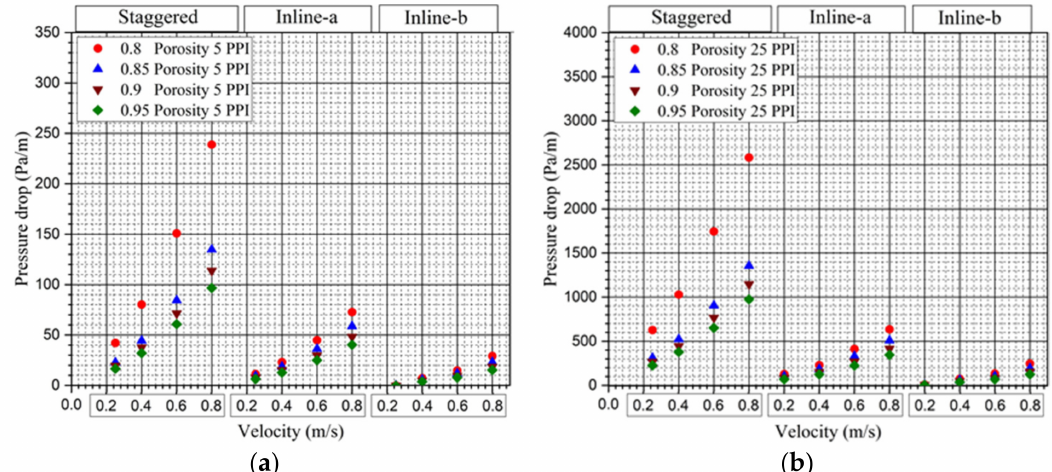
Figure 18. ( a ) Variation of pressure drop for 5 PPI (pore-density/mesh-size) wire mesh samples of different porosity for all three stacking scenarios. ( b ) Variation of pressure drop for 25 PPI (pore- density/mesh-size) wire mesh samples of different porosity for all three stacking scenarios.